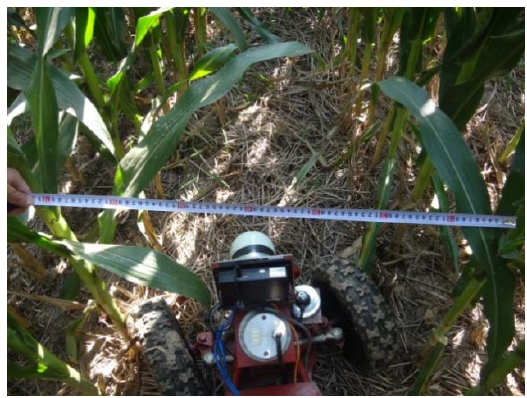
Figure 5. The vehicle’s moving environment.